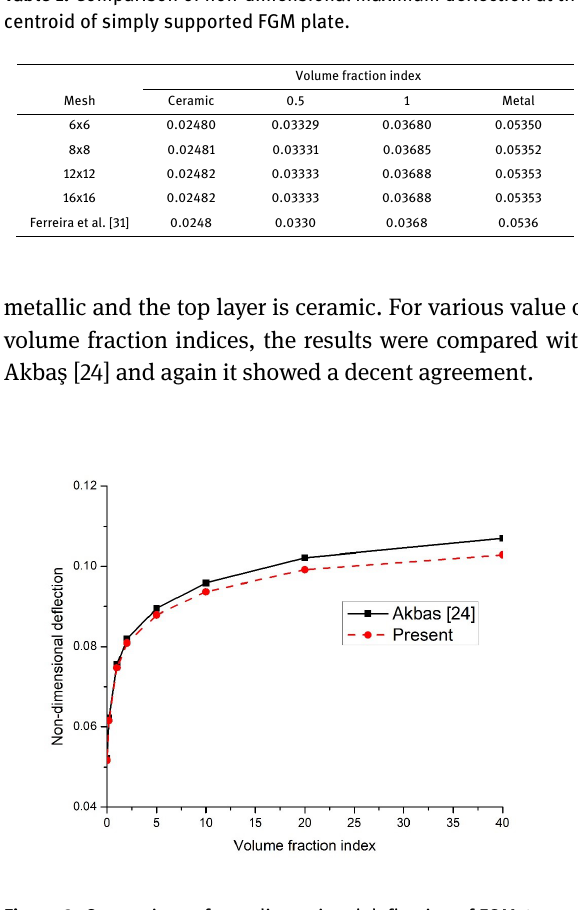
Figure 2: Comparison of non-dimensional deflection of FGM-1 porous plate subjected to uniform loading.